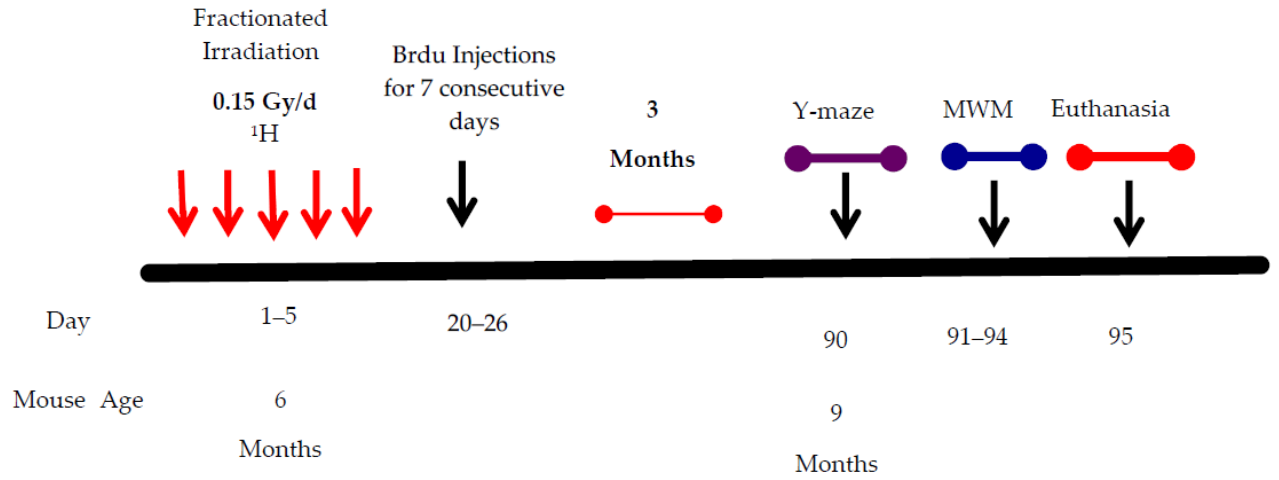
Scheme 1. Timeline of experimental design for fractionated irradiation, behaviorial testing and eu-